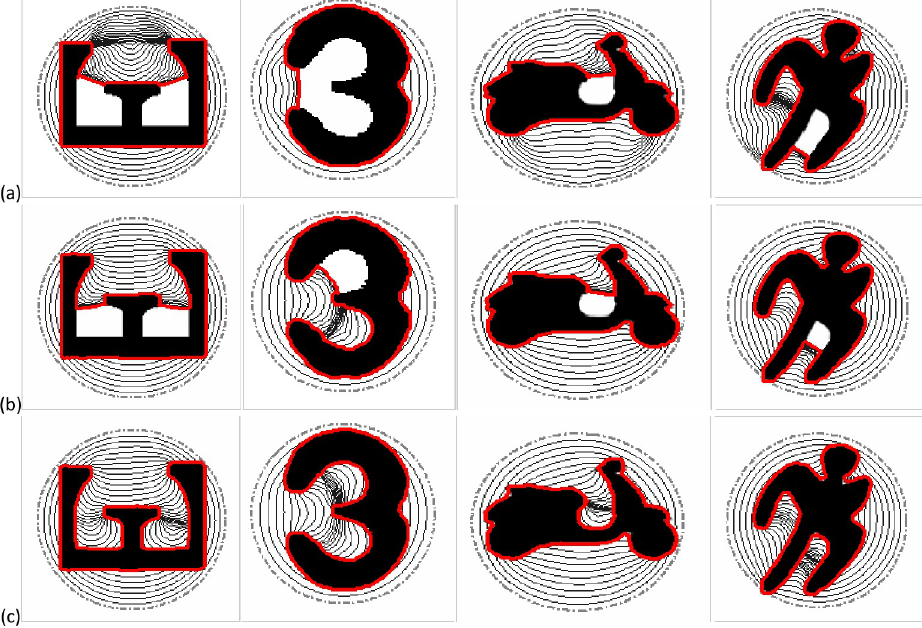
Fig 8. Deep concavity convergence. The segmentation results of (a) the GVF snakes with μ = 0.2, (b) the VEF snakes, and (c) the MCONVEF snakes with h = 0, k = 0.2, L = 2.